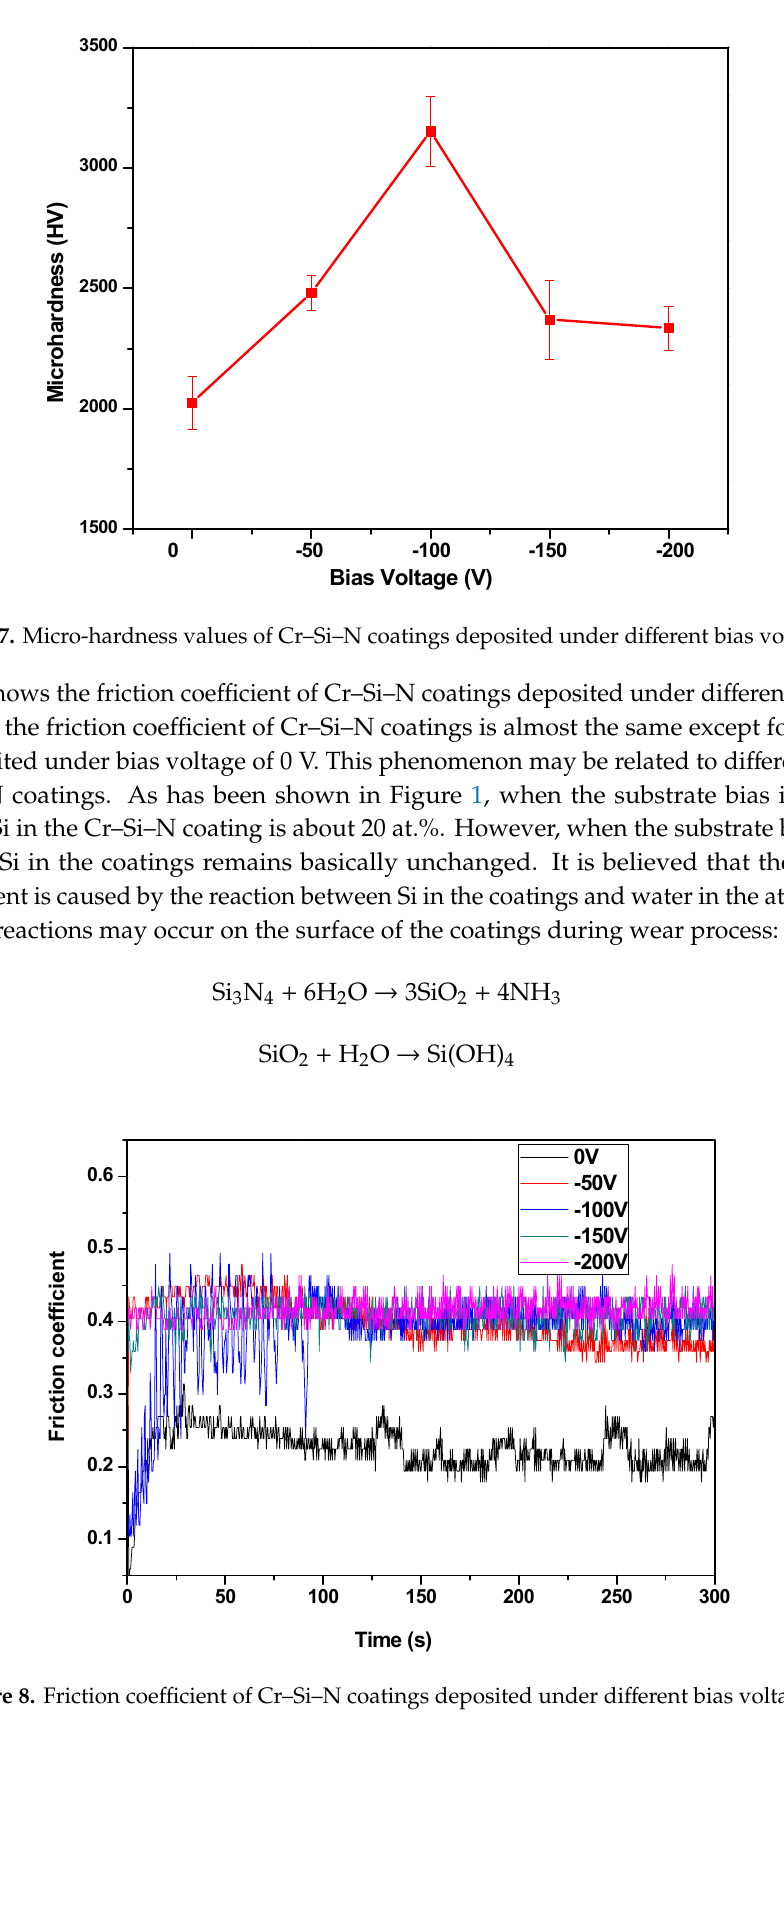
Figure 8. Friction coefficient of Cr–Si–N coatings deposited under different bias voltages.